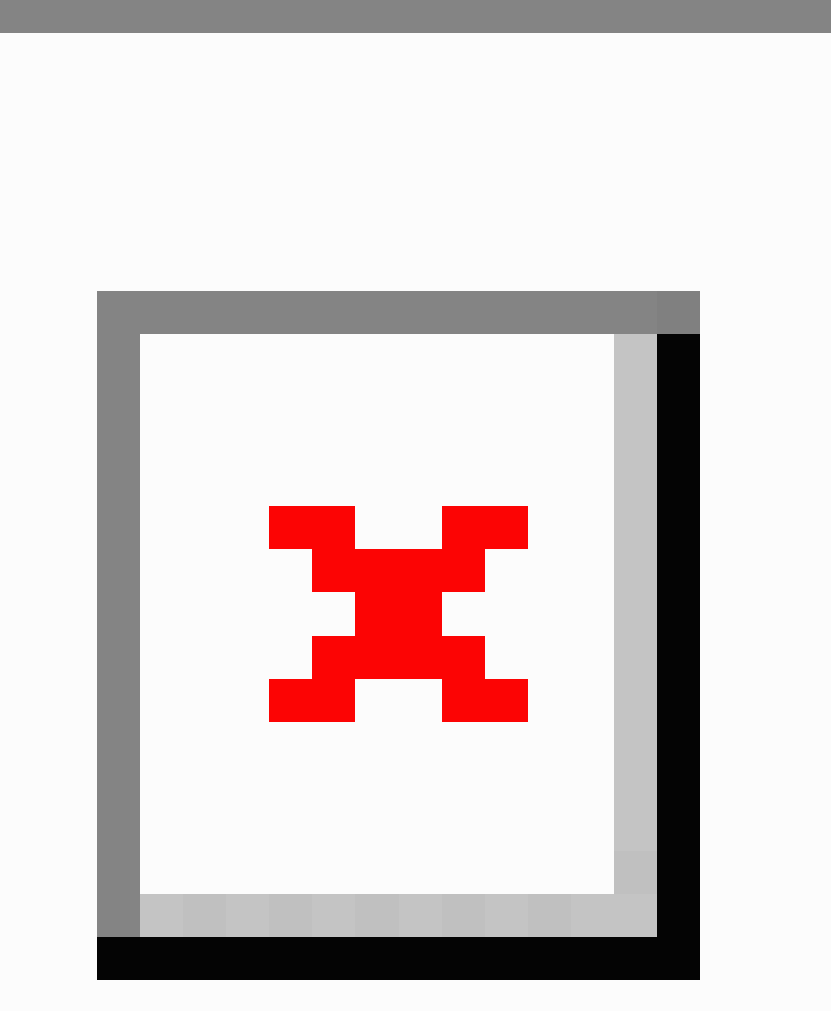
Figure 2. Frequency of appearance of each patient need within the 124 selected articles and the share of peer-reviewed articles for each need. The total percentage is higher than 100 because some articles include technologies used to address more than one patient